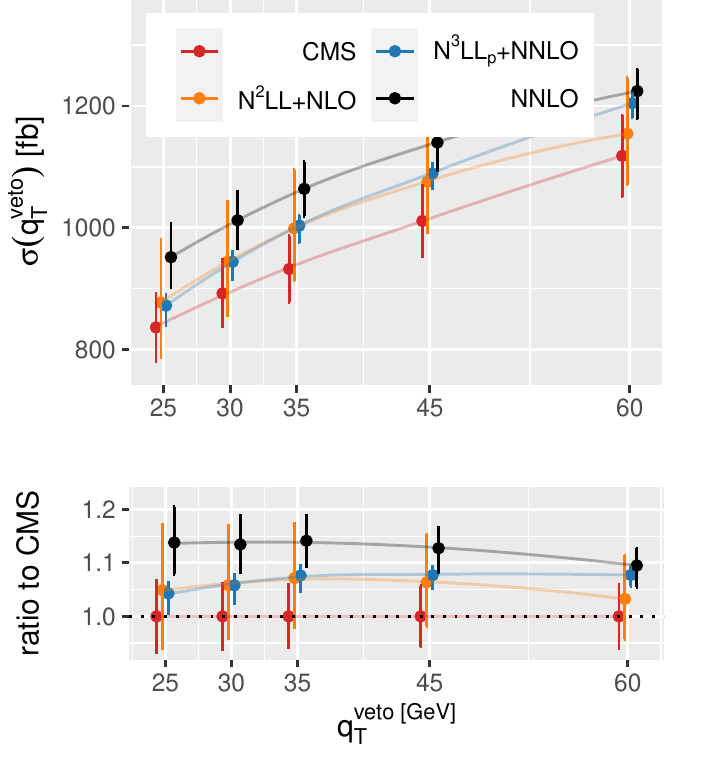
Figure 9 . Jet-veto resummed cross-sections for W + W − → 2 e 2 ν production at 13 TeV using the CMS cuts in table 7 of this section in comparison with the CMS measurement [28]. The solid lines are interpolations to guide the